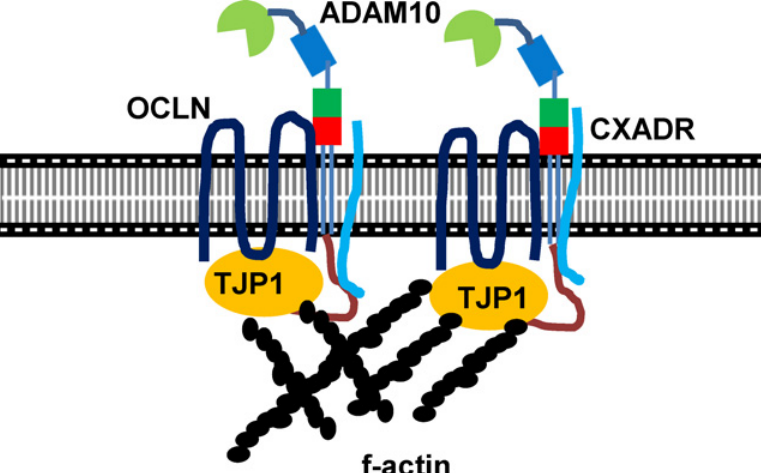
Fig 6. A model of ADAM10 during blastocyst formation. The SH3 domains of CXADR and TJP1 interact with SH2 binding motif of the cytoplasmic domain of ADAM10. Tetraspanin proteins such as OCLN interact with the extracellular domains of ADAM10 or with TJP1, suggesting that the clustering of AJ and TJ mediated by ADAM10 provides strong TJ assembly and paracellular sealing, and leads to cavitation and expansion from the transition stage between morula and blastocyst and